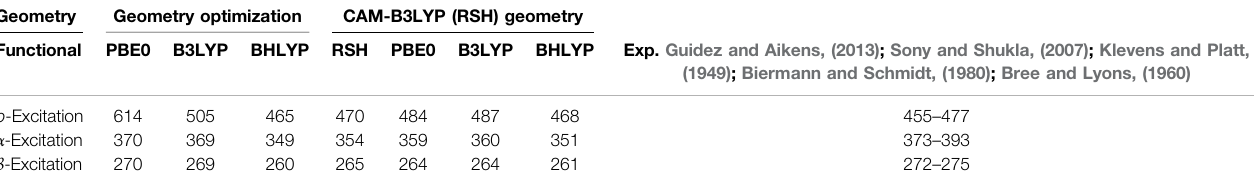
TABLE 2 | Wavelengths of p -, α - and β -excitations in nm as calculated at the CD-ev GW /BSE@DFT level employing different reference functionals. In order to highlight the dependence onthegeometry,allcalculationswereperformedbothonthegeometryasoptimizedusingthereferencefunctionalaswellasonthegeometryasoptimized using the range-separated hybrid (RSH) functional CAM-B3LYP. Experimental values are also given. Geometry